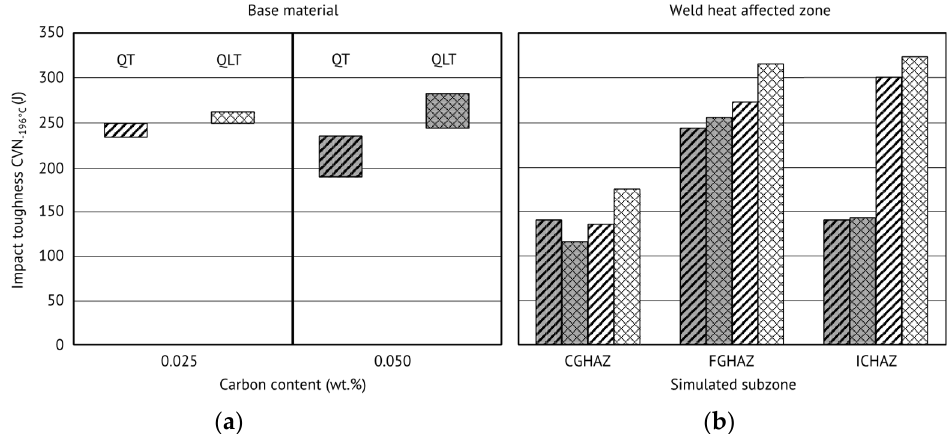
Figure 17. ( a ) Options for optimizing 9%Ni steel by reducing the carbon content and/or applying double quench and tempering (QLT). ( b ) Effect of these optimization on the properties of the weld heat affected zone.